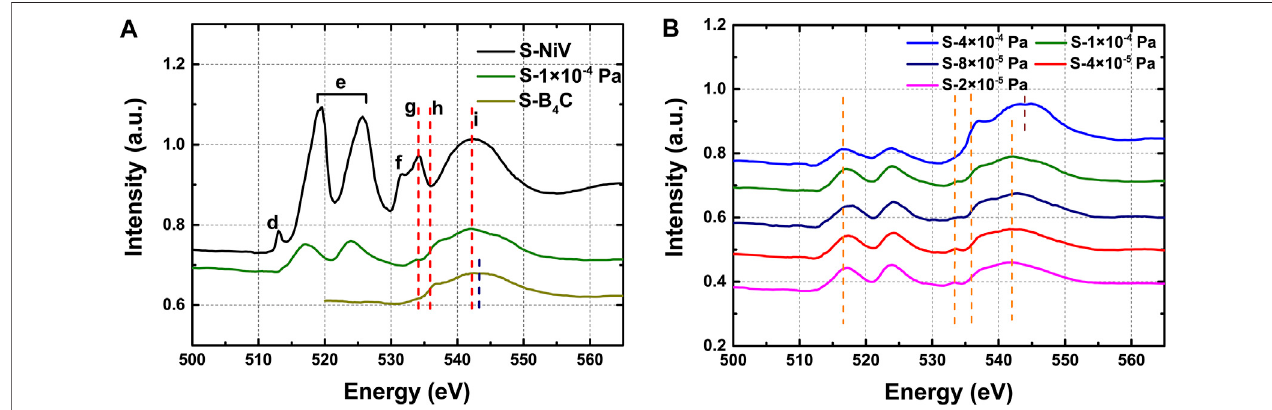
FIGURE5| TheVL-edgeandOK-edgeXANESspectraofdifferentsamples. (A) NiV/B 4 C MLandNiVcoatingdeposited with1×10 − 4 Pa,B 4 Ccoatingdeposited with 6 × 10 − 5 Pa. (B) NiV/B 4 C MLs deposited with different background pressures (S-4 × 10 − 4 , S-1 × 10 − 4 , S-8 × 10 − 5 , S-4 × 10 − 5 , and S-2 × 10 − 5 Pa).